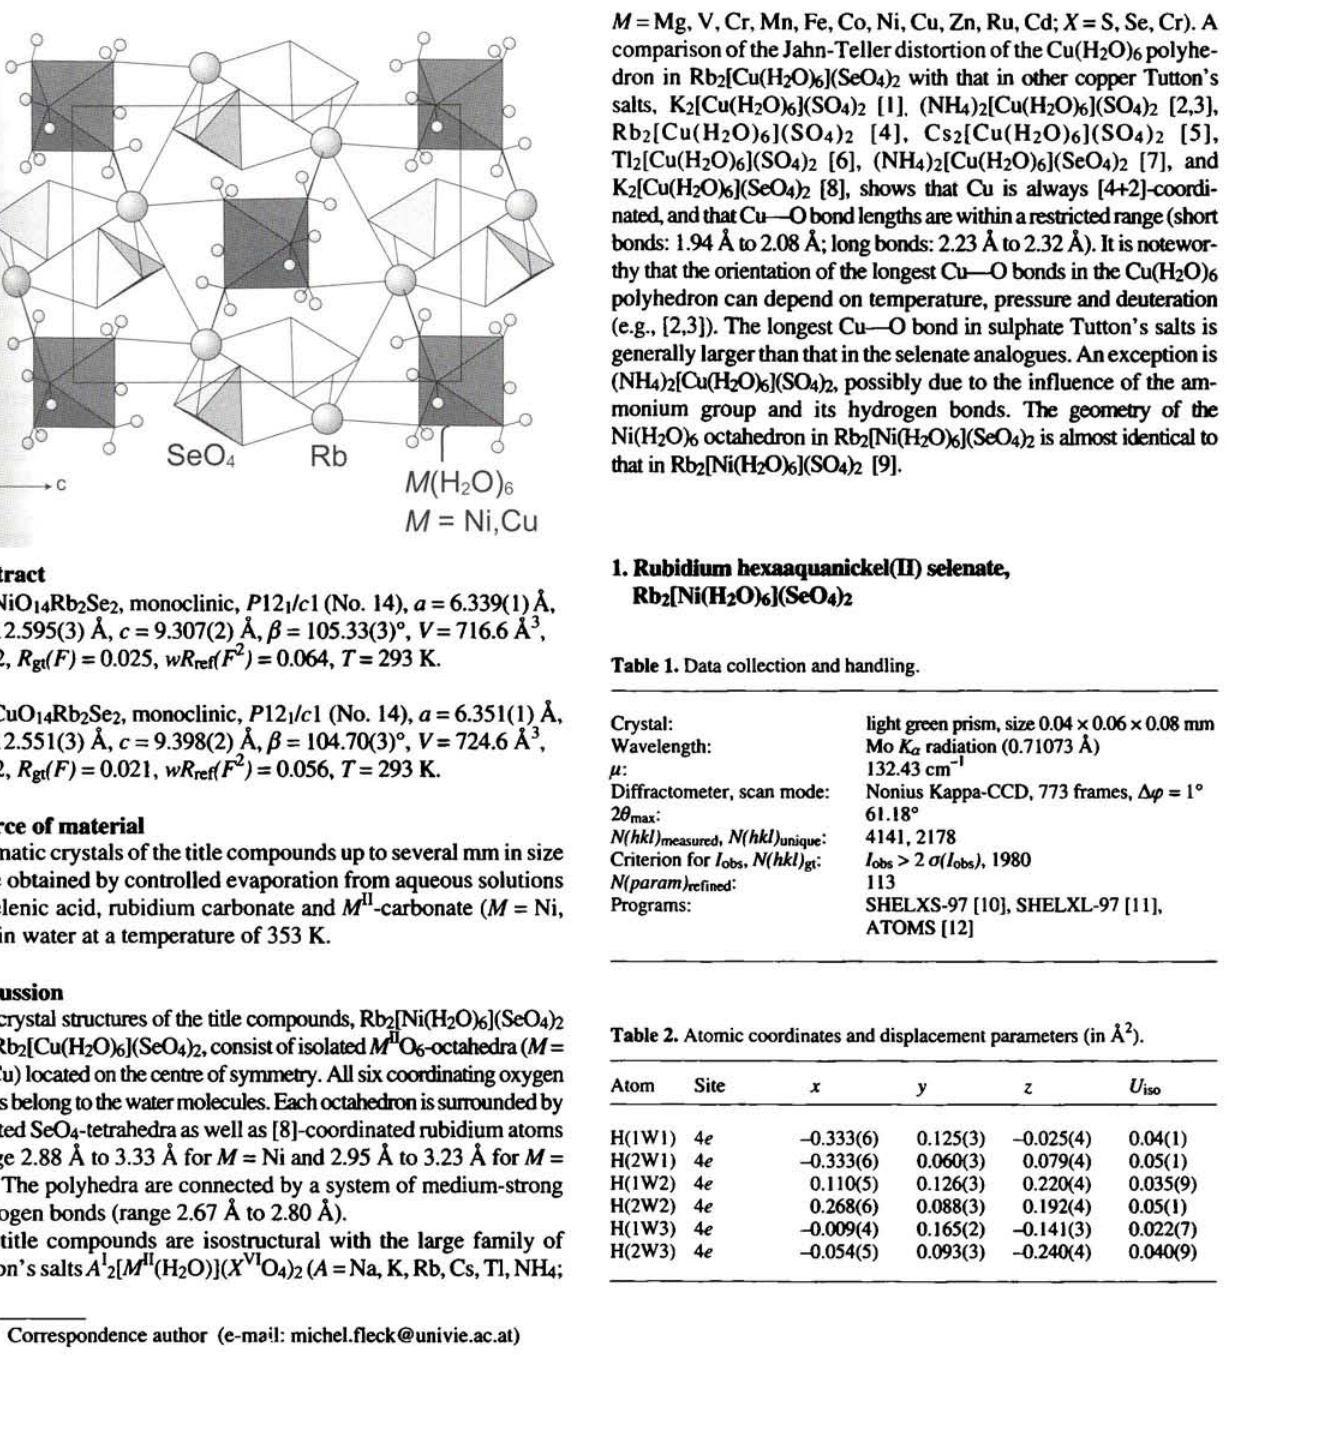
Table 2. Atomic coordinates and displacement parameters (in Â 2